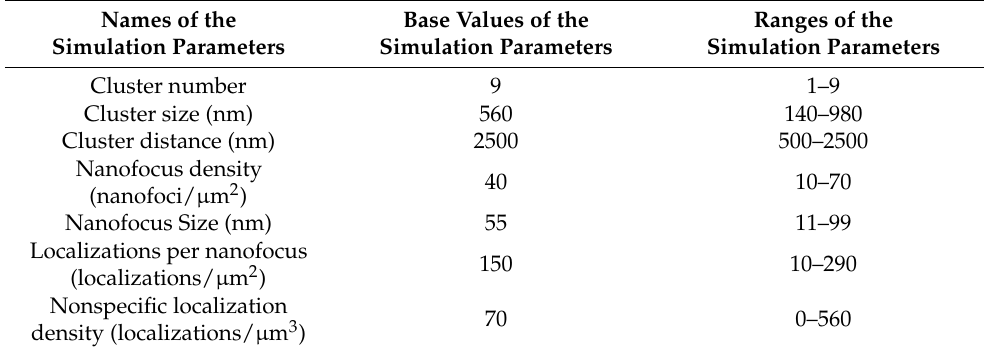
Table 1. Table showcasing the values of the simulation parameters and their respective